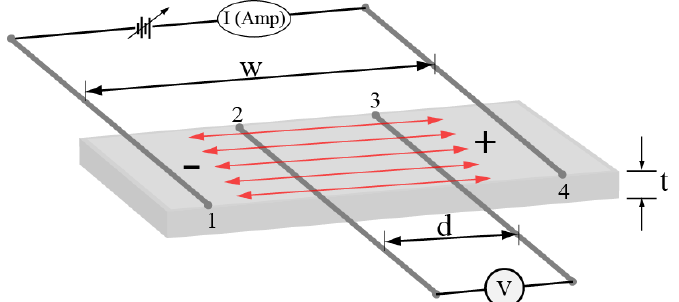
Figure 3. Physical model for measuring the resistivity and volume resistivity of the